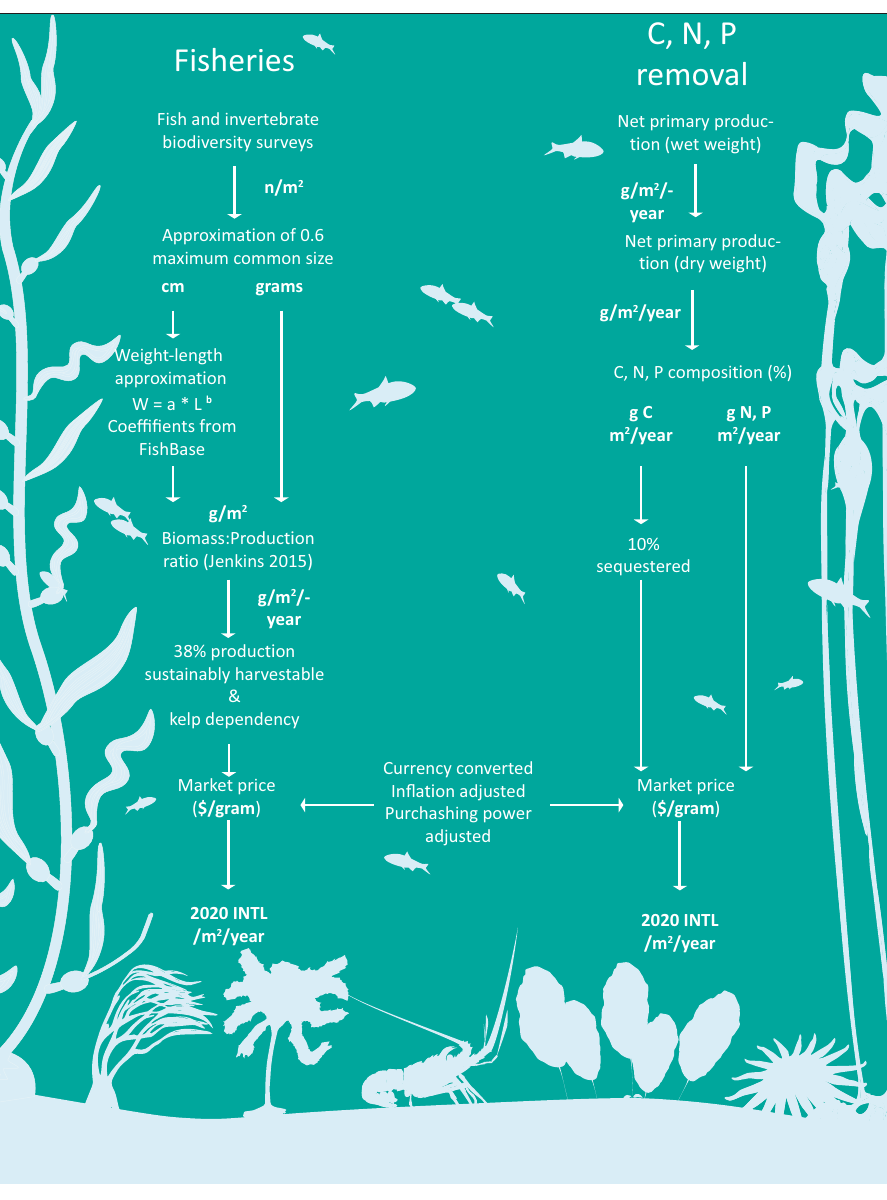
coef fi cients. Image credit: Tim Carruthers, Integration and Application Network (ian.umces.edu/media-library) for the Ecklonia , Laminaria, Lessonia, Macrocystis, Nereocystis , sea star, lobster, and fi sh